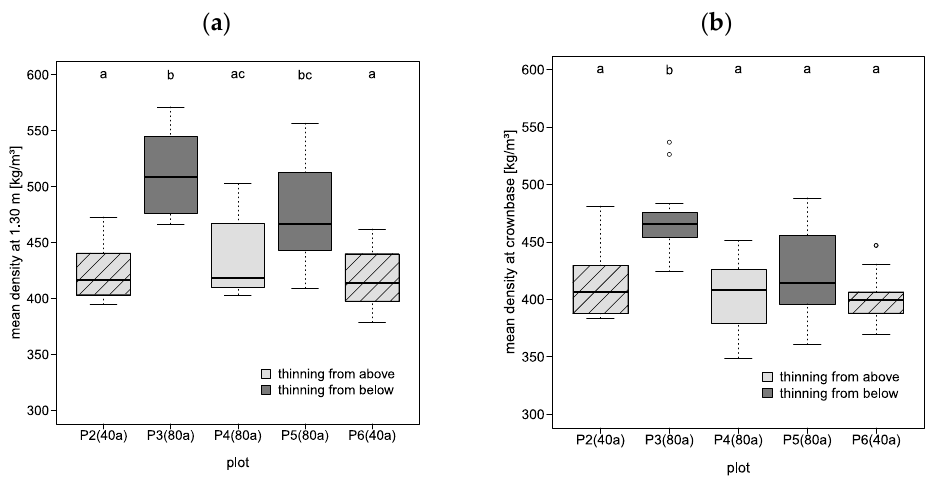
Figure 4. Range of mean density [kg · m − 3 ] at DBH ( a ) and at CBH ( b ) for the investigated five plots with different silvicultural treatment (light gray: TFA, dark gray: TFB; hatched: age group 40, not hatched: age group 80). Letters (a–c) indicate significant differences between the plots at p < 0.05 (non-parametric, Kruskal–Wallis test with Bonferroni correction).